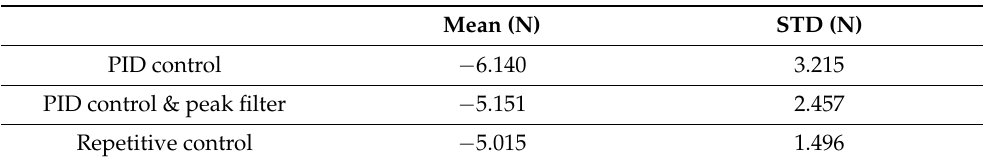
Table 4. The contact force between the workpiece and the grinding tool using different force control methods.